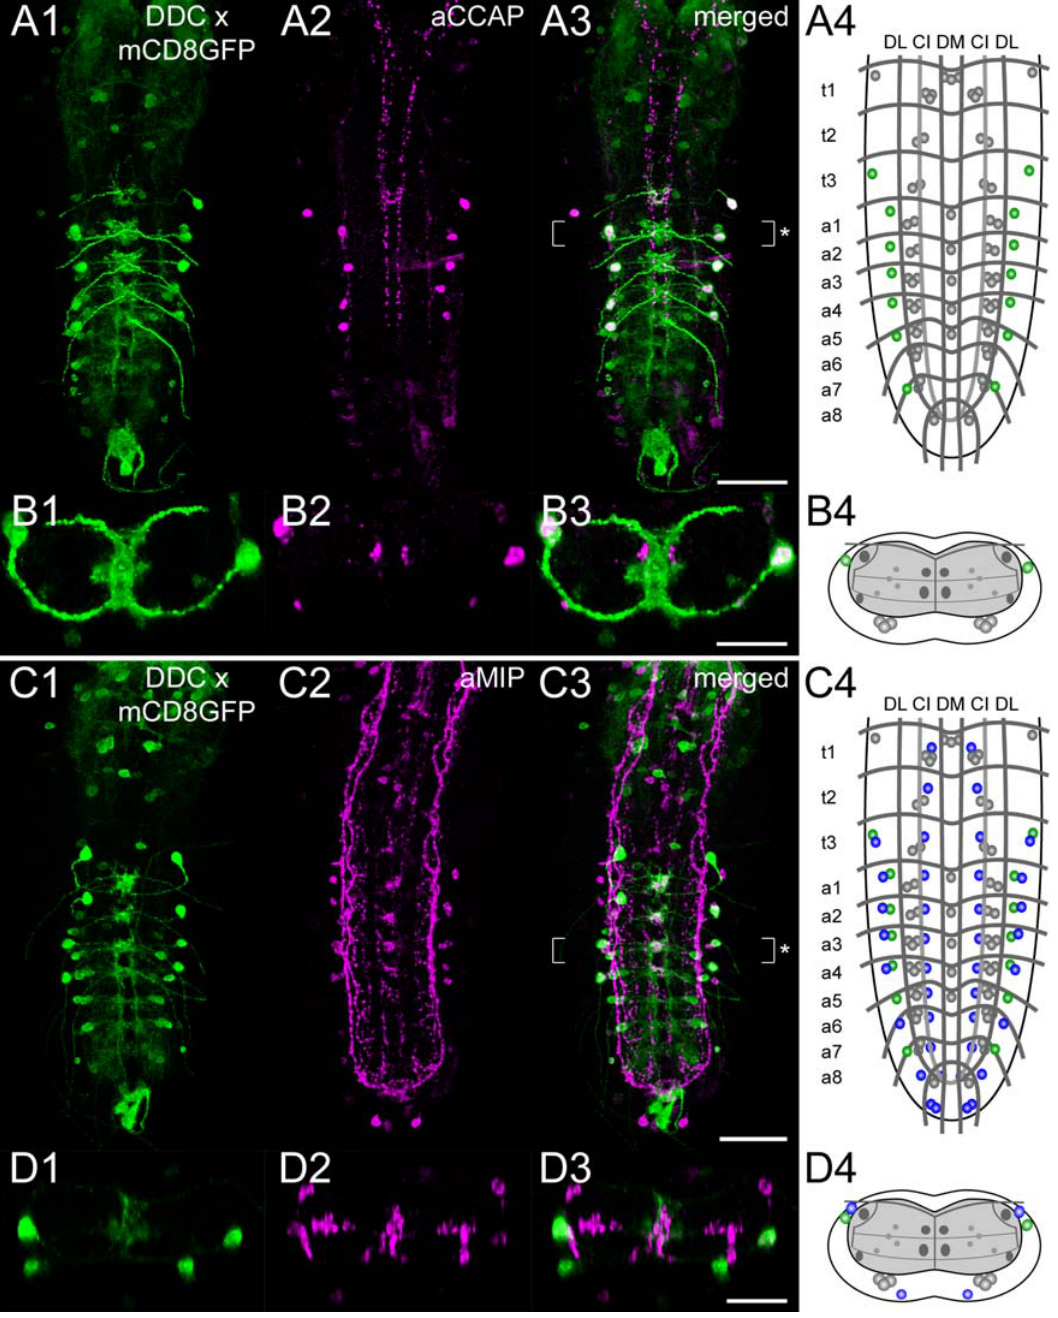
Figure 10. Fas2-based comparison of Ddc-gal4 -driven mCD8GFP expression and CCAP/MIP immunoreactivity in the larval VG. A1) Dorsal view of Ddc-gal4 x mCD8GFP expressing neurons (green) and A2) CCAP-immunoreactive neurons (magenta) in a larval VG. The merged image (A3) served for an idealized schematic representation of the respective neuron groups in the Fas2 landmark system (A4). B1-3) Corresponding transversal views of the neuromere a1 (* in A3), and B4) the deduced idealized scheme. C1) Dorsal view of Ddc-gal4 x mCD8GFP expressing neurons (green) and C2) MIP-immunoreactive neurons (magenta) in a larval VG. The merged image (C3) provided the basis for the scheme shown in (C4). D1- 3) Corresponding transversal views of the neuromere a3 (* in C3), and D4) the deduced idealized scheme. In all schemes, neurons showing both Ddc- gal4 -driven mCD8GFP expression and CCAP/MIP immunoreactivity are green-colored. Ddc-gal4 x mCD8GFP expressing neurons which lacked CCAP/ MIP immunoreactivity are shown in gray. Vice versa, neurons which exclusively showed CCAP/MIP immunoreactivity are blue-colored. Original images are maximum pixel intensity projections of volume-rendered 3D image stacks. Scale bars: 50 m m in A) and C), 25 m m in B) and D).